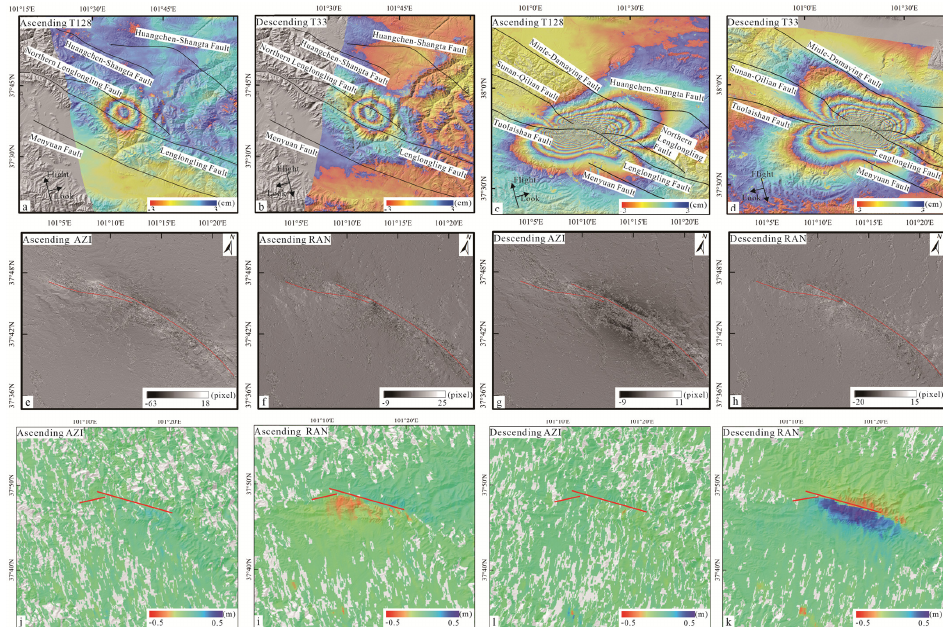
Figure 3. SAR image processing results. ( a , b ) InSAR coseismic deformation fields of the 2016 Menyuan earthquake’s ascending and descending tracks. ( c , d ) InSAR coseismic deformation fields of the 2022 Menyuan earthquake’s ascending and descending tracks. ( e – h ) Phase gradient images of the 2022 Menyuan earthquake’s ascending and descending tracks. ( j – k ) POT images of the 2022 Menyuan earthquake’s ascending and descending